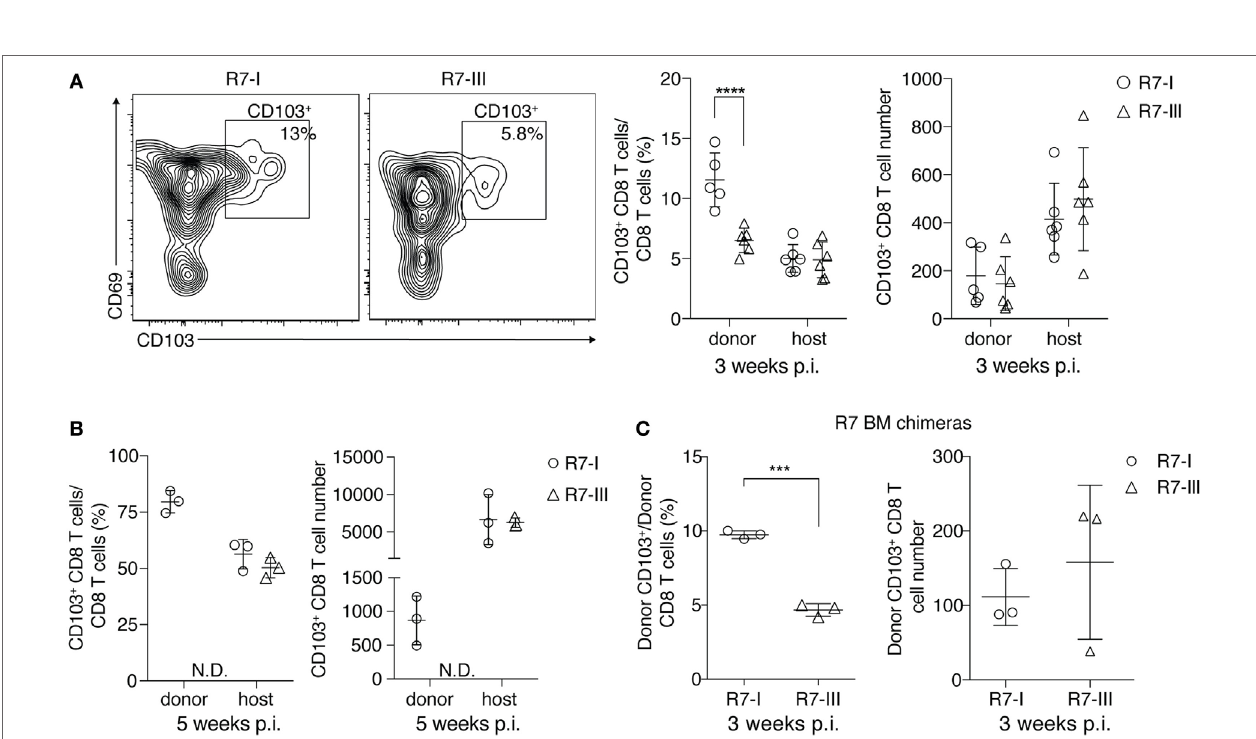
FigUre 4 | R7-III has a higher contraction rate and does not persist into the late phase of chronic Toxoplasma gondii infection. ROP7 CD8 T cells were adoptively transferred into congenic mice before Toxoplasma infection. Spleen, mesenteric LN and popliteal and axillary lymph nodes and brains were harvested and analyzed by flow cytometry (a–e) . (a) Percentages and total cell numbers of donor Rop7 CD8 T cells in the brain and spleen 3 and 5 weeks post-infection (p.i.) (representative of at least five experiments with two or three mice per cell line per experiment). * p ≤ 0.05, ** p ≤ 0.01, *** p ≤ 0.001, two-way analysis of variance followed by Tukey’s multiple comparisons test. (B) Donor population was assessed for expression of CD127 (IL7Ra) and KLRG1 at 3 and 4 weeks p.i. (representative of at least five experiments). (c) PD1 expression on donor CD8 T cells in the brain 3 weeks p.i. and their potential to produce IFN γ after ex vivo restimulation with PMA/Ionomycin (representative of two experiments). * p ≤ 0.05, ** p ≤ 0.01, *** p ≤ 0.001 by Student’s t -test. (D) CXCR3 surface staining on donor CD8 T cells 10 days p.i. in brain and spleen together with representative histogram plots of CXCR3 expression of donor R7 CD8 T cells in the brain and spleen 10 days p.i. (e) Percentages of R7 CD8 T cells in brain and spleen of R7 bone marrow chimeras at 3 and 5 weeks (minimum of three mice analyzed per condition) p.i. *